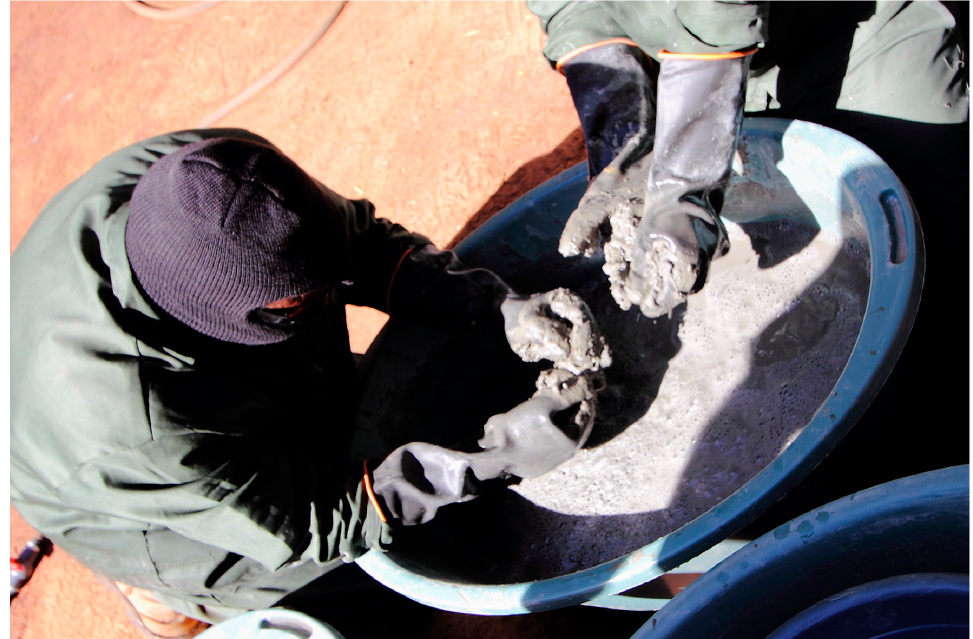
Figure 2. Remixing the material into a slurry and removing some of the plastic, fibers, and woodchips present.